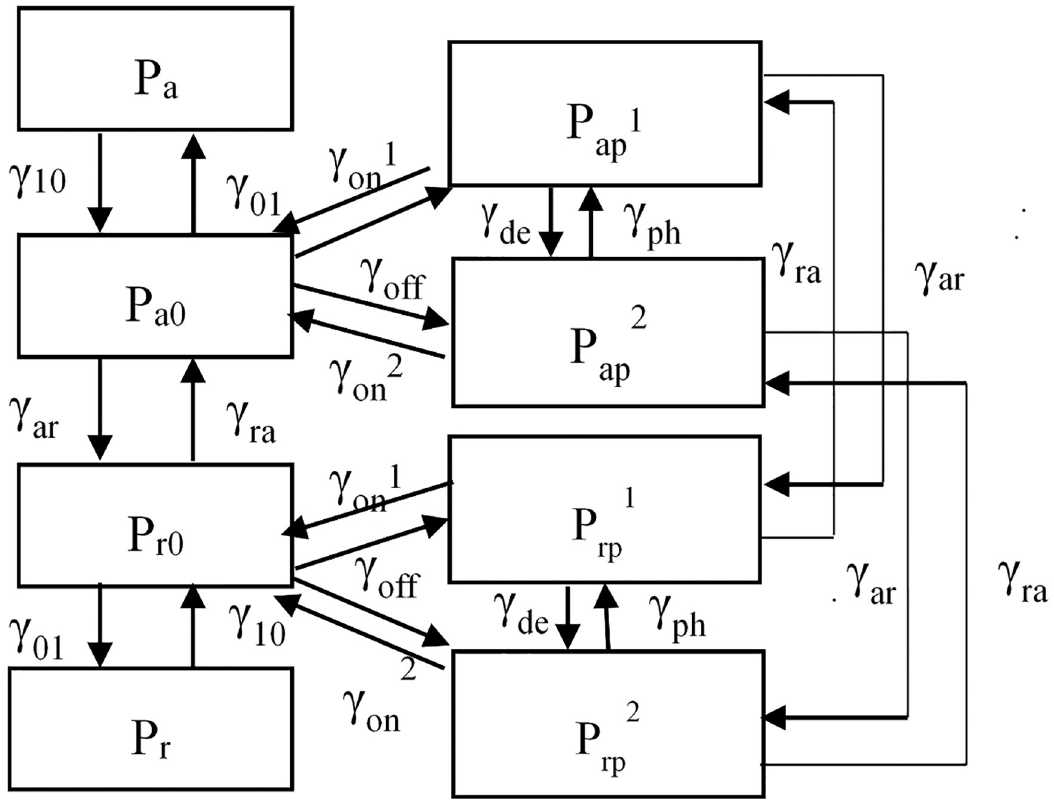
Fig 10. Schematic diagram of the ‘8-state’